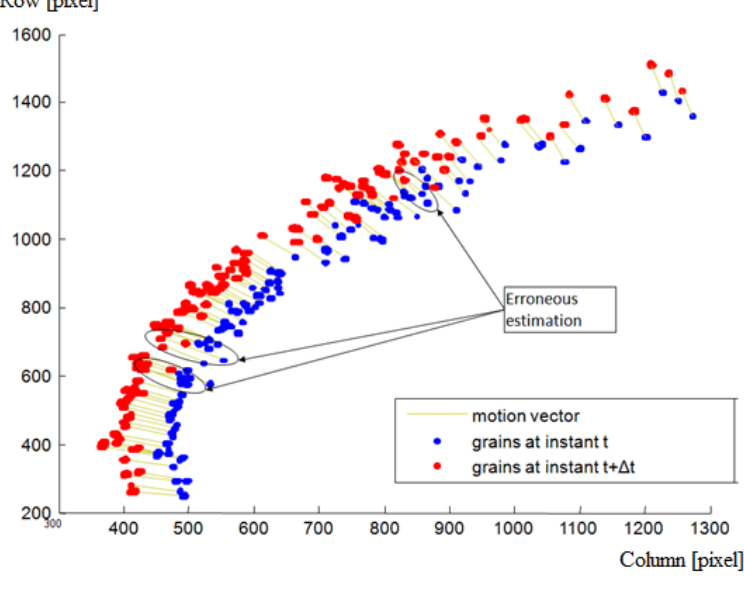
Figure 8. Corrected displacements based on the consistency and uniqueness